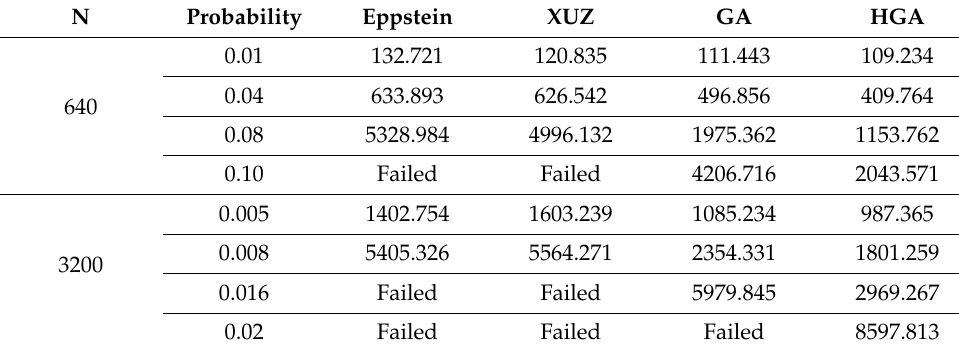
Table 5. Run time of counterexample generation.